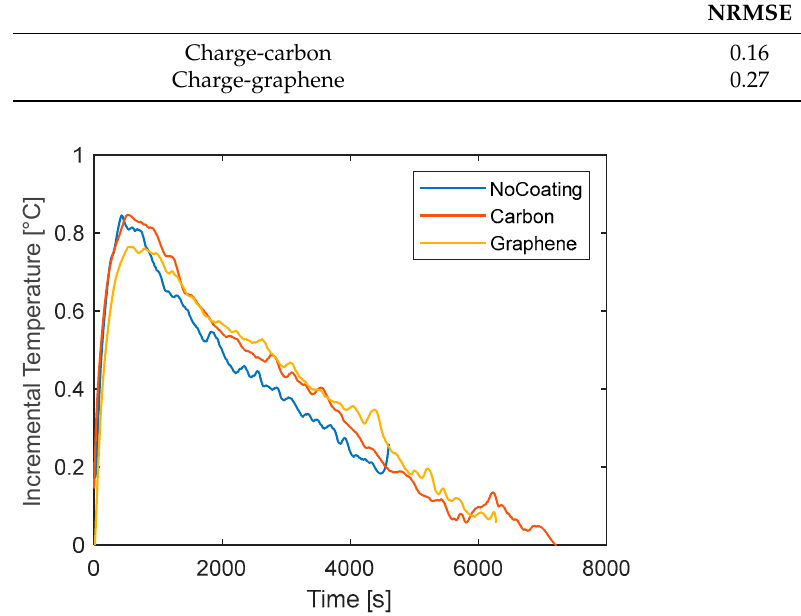
Figure 9. Curves of temperature versus time for different coatings for charge tests. Table 5. NRMSE between the curve of temperature for the uncoated and coated battery during charge mode.